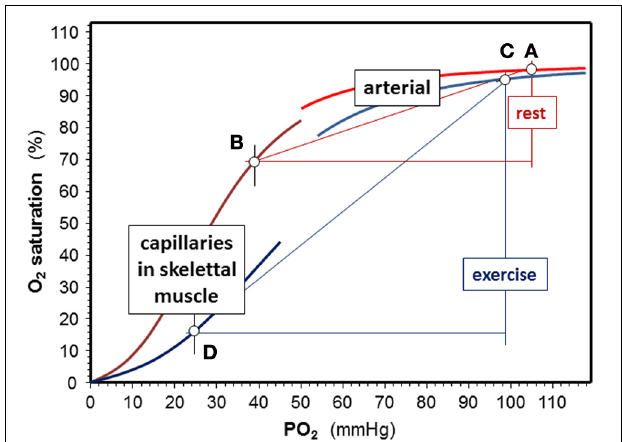
FIGURE 2 | Effects of exercise on Hb-O 2 affinity. Shifts of the O 2 -dissociation curves are calculated for an arterial pH = 7.4, a capillary pH = 7.3, and temperature is 37 ◦ C rest. Values used to calculate oxygen dissociation curves (ODC) for exercise were an arterial pH = 7.15 at 38.5 ◦ C, a capillary pH = 7.0 and temperature = 41 ◦ C in working muscle using the equation giving in the text using data from exercise tests (Sun et al., 2000). At rest, assuming a venous PO 2 = 40mmHg, SO 2 decreases by 28% (points A and B ), while extraction nearly triples in exercise conditions (delta SO 2 = 79%) assuming a venous PO 2 = 25mmHg during exercise (points C and D